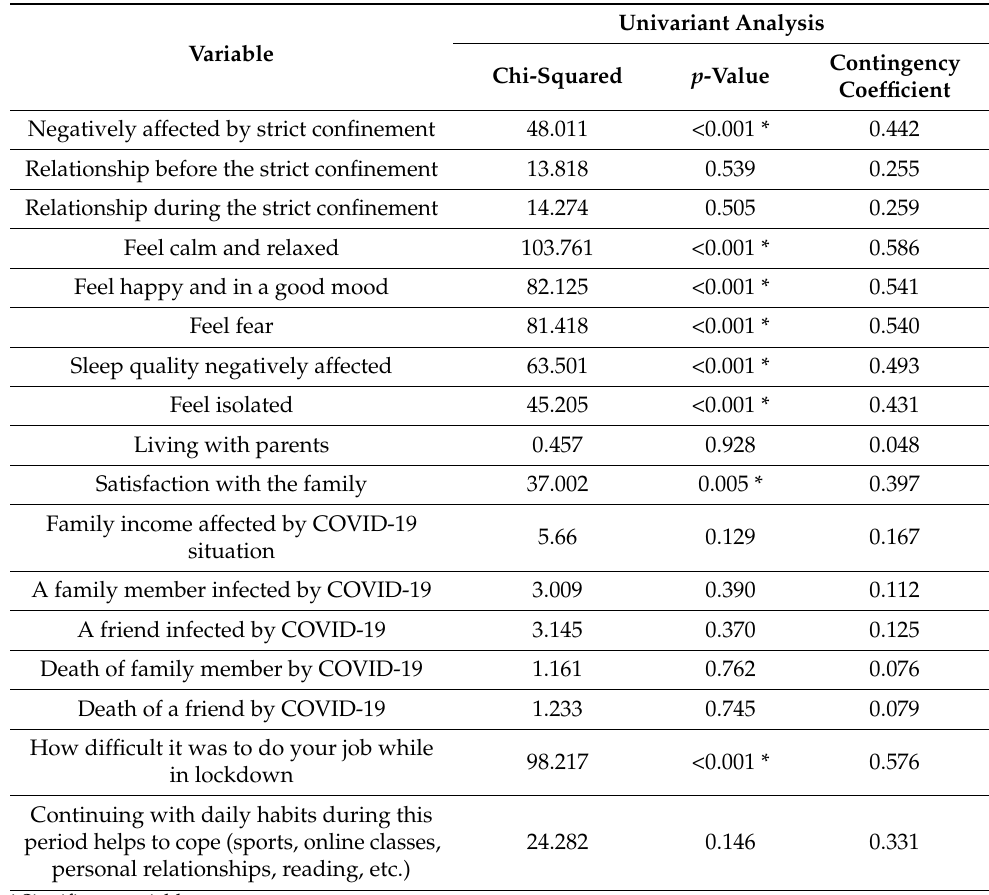
Univariant Analysis Contingency Chi-Squared p -Value Coefficient